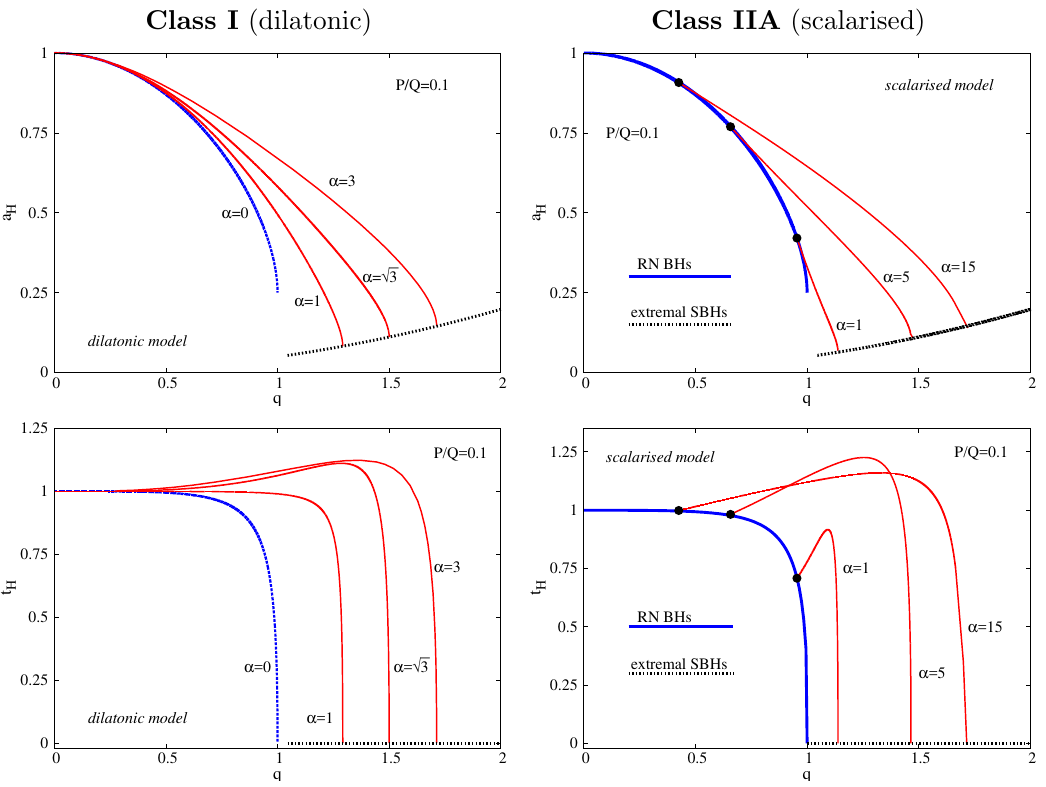
Figure 4 . Same as (cid:12)gure 1 but now for dyonic BHs. The ratio between magnetic and electric charges is P=Q = 0 :